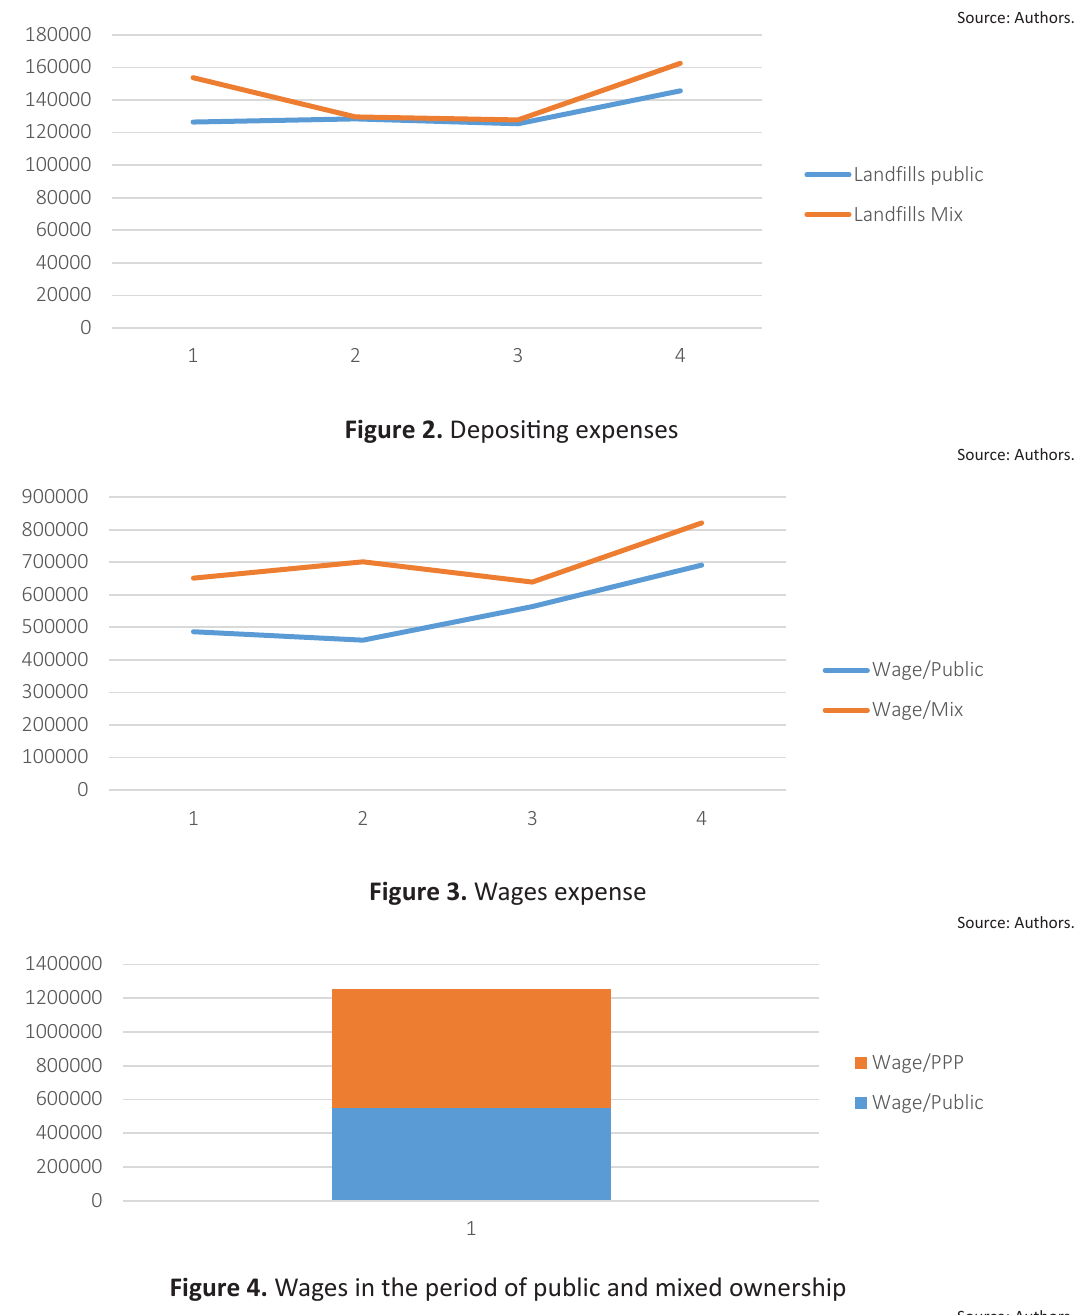
Figure 4. Wages in the period of public and mixed ownership